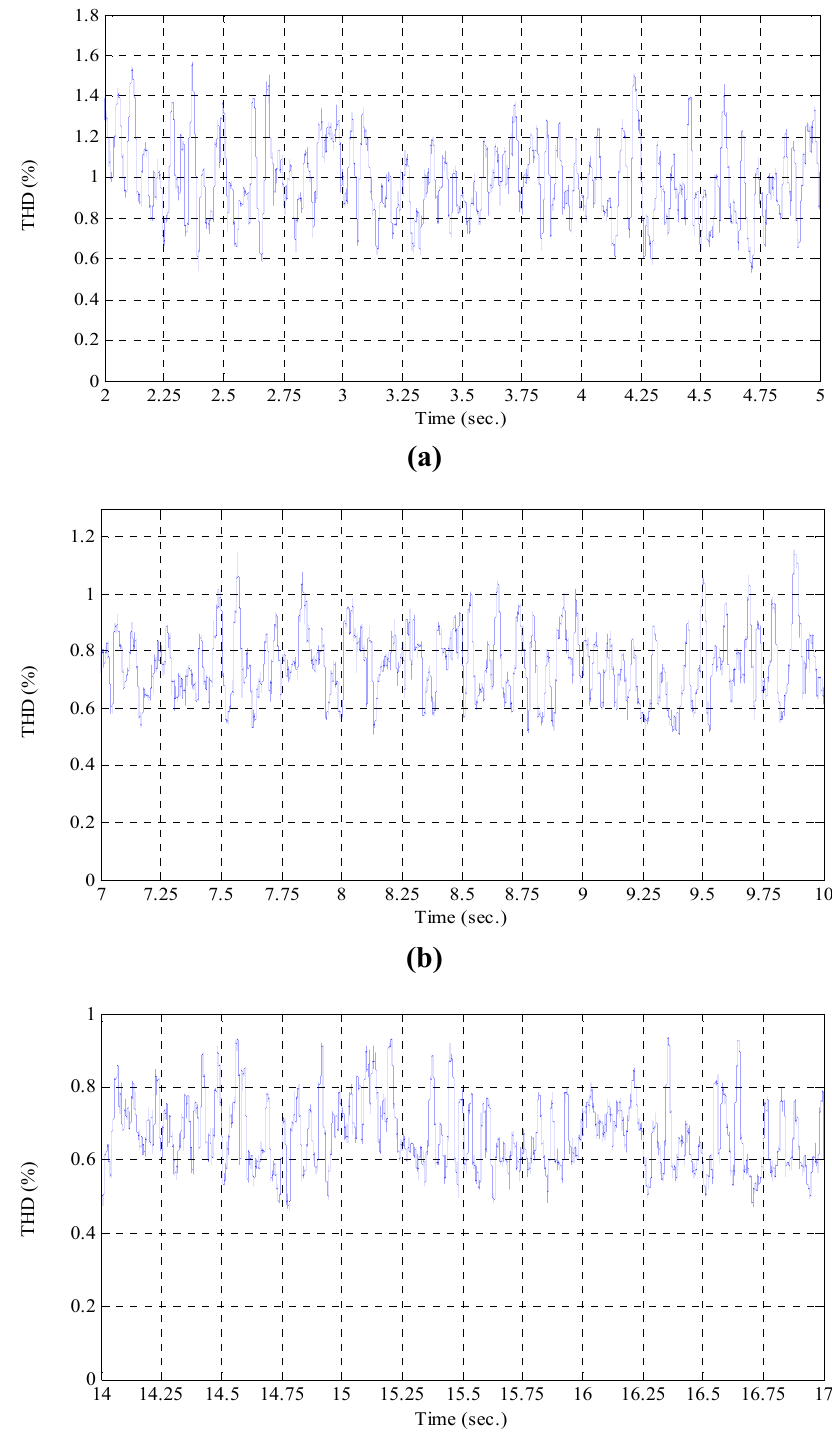
Figure 16. The total harmonic distortion (THD) for the output current for different load situations. ( a ) The THD for the output current when the required load power is 12 kW; ( b ) The THD for the output current when the required load power is 13.5 kW; ( c ) The THD for the output current when the required load power is 15